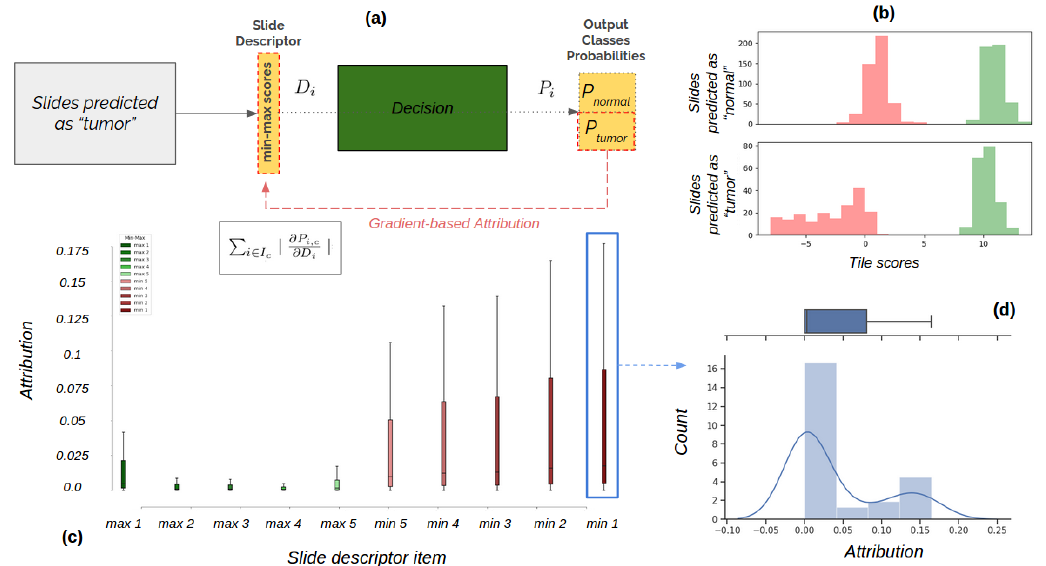
Figure 3. Slide descriptor attribution for the “tumor” class; ( a ) Illustration of gradient on the learned “Decision” block; ( b ) Distributions of min and max scores w.r.t. predicted class; ( c ) Distributions of attribution on each slide descriptor items (5-min scores and 5 max-scores); ( d ) Detail on the distribution of attribution for min 1 (lowest) tile score item and bimodal Gaussian